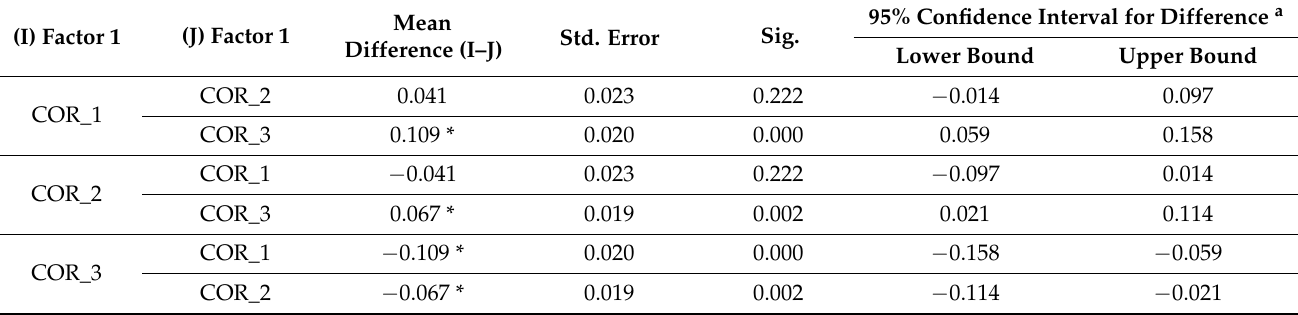
Table A1. Pairwise comparisons for paired differences in hair cortisol during three time